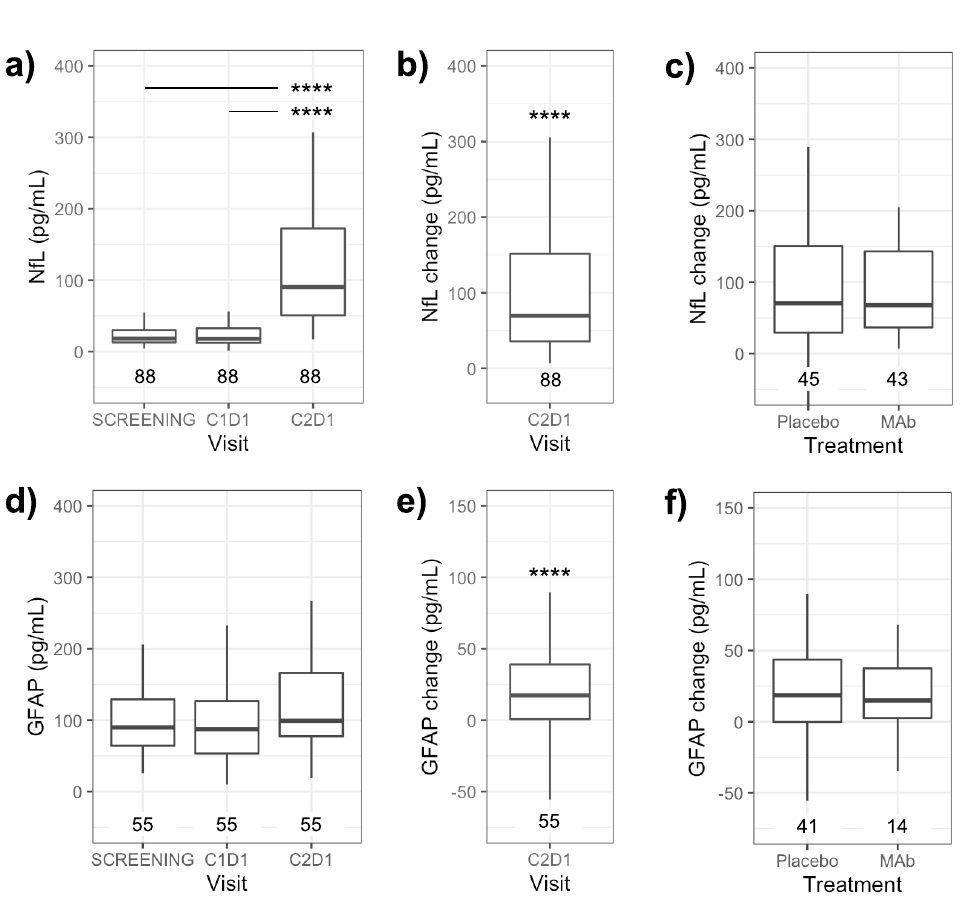
Figure 3. NfL and GFAP in serum are elevated with chemotherapy treatment. ( a ) Serum NfL prior to (screening and C1D1) or 21 days after (C2D1) treatment with paclitaxel and carboplatin. ( b , c ) NfL change from baseline, defined as C2D1 levels minus the average of screening and C1D1 levels ( d ) GFAP levels for all visits or ( e ) GFAP change at C2D1. ( f ) GFAP change by treatment arm.**** p < 0.0001 by Dunn’s test: panel ( a ) and ( c ) or Wilcoxon signed rank test: panel ( b ) and ( e